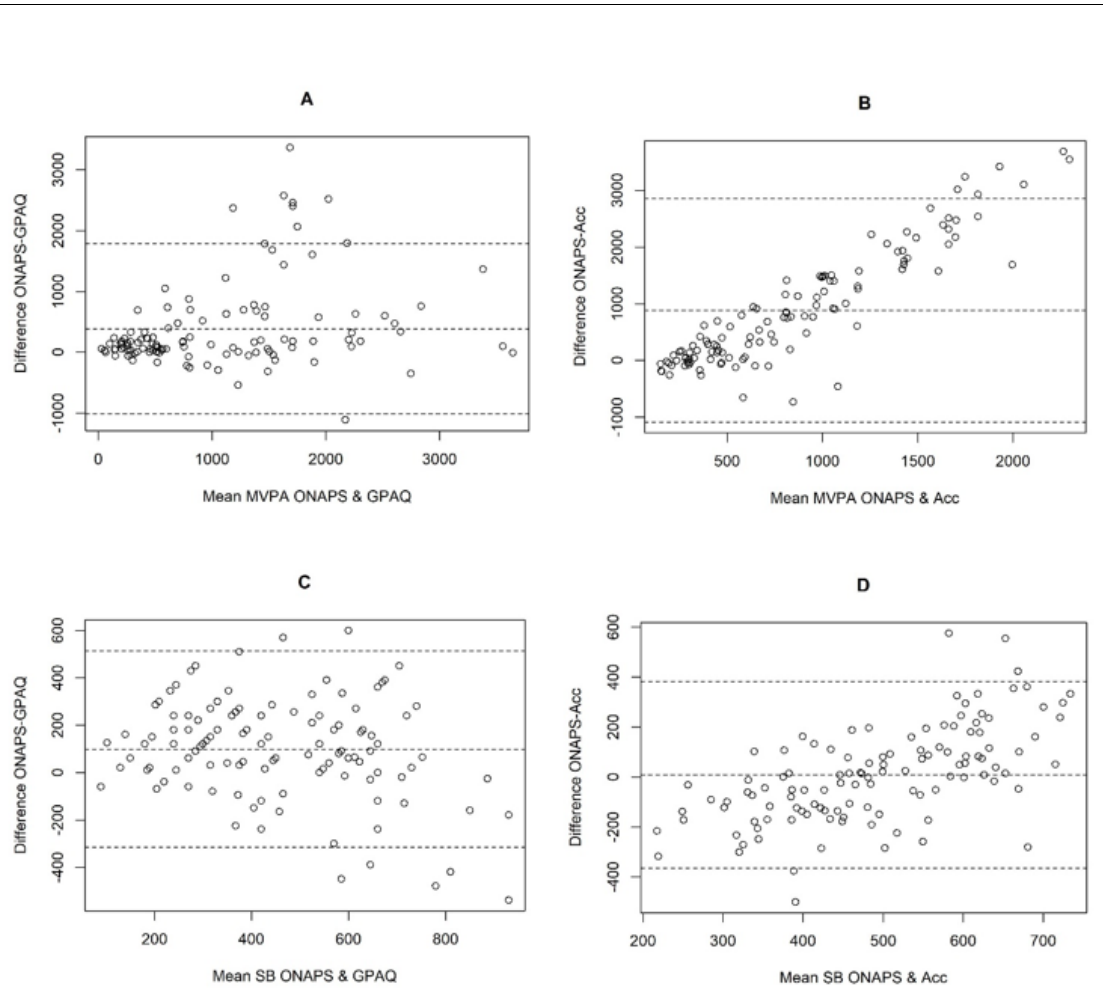
Figure 1. Bland–Altman plots for the agreement of data assessed with ONAPS-PAQ, GPAQ, and accelerometer (Acc). MVPA, moderate-to-vigorous physical activity (min · week − 1 ); SB = sedentary behavior (min · day − 1 ). ( A , C ): agreement of ONAPS-PAQ with GPAQ for MVPA and SB; ( B , D ): agreement of ONAPS-PAQ with RM42 accelerometer for MVPA and SB. ONAPS-PAQ = national observatory of physical activity and sedentariness-physical activity questionnaire; GPAQ = global physical activity questionnaire.